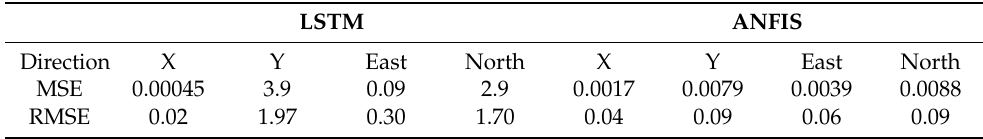
Table 2. Training results of the LSTM and ANFIS